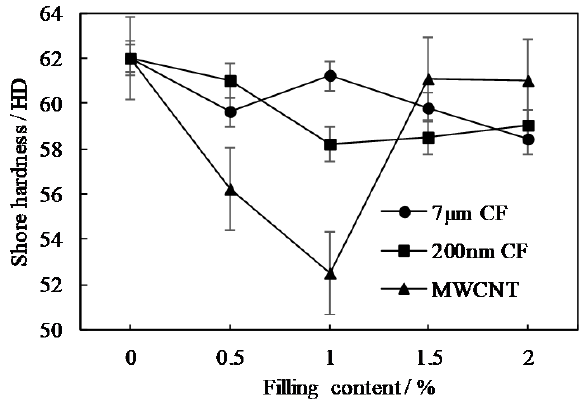
Figure 6. Hardness of micro / nano CF and multiwalled carbon nanotube (MWCNT) filled modified PTFE composites.